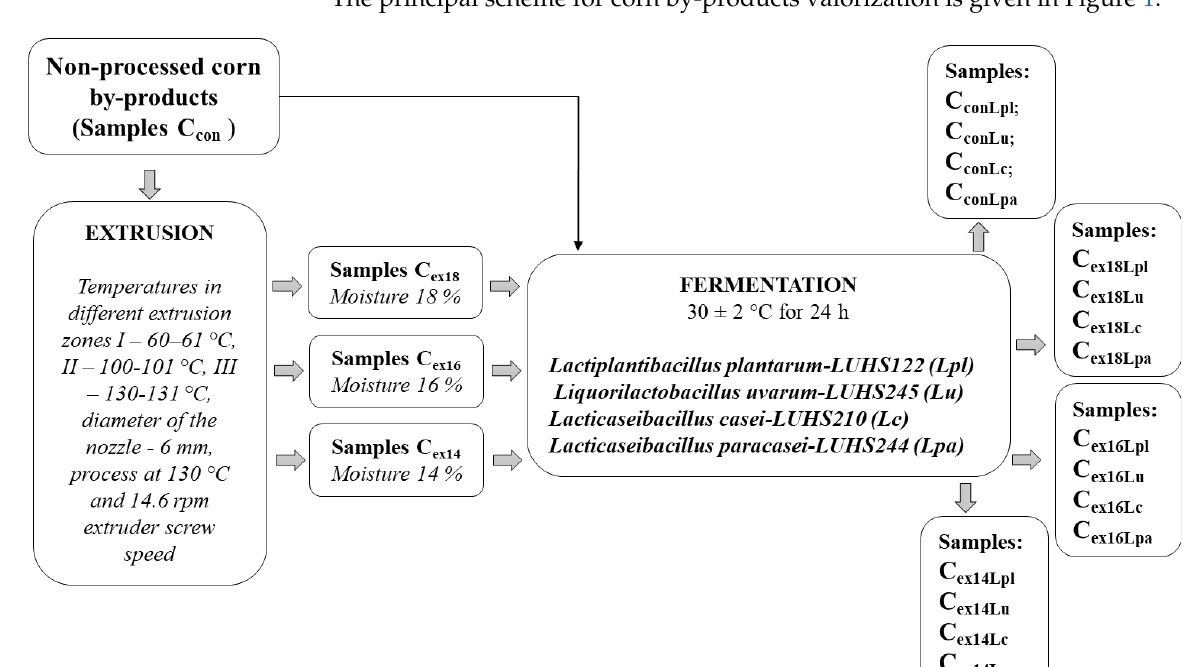
Figure 1. The principal scheme for corn by-products valorization.